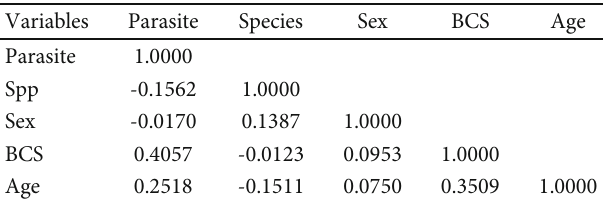
Table 5: Correlation analysis.